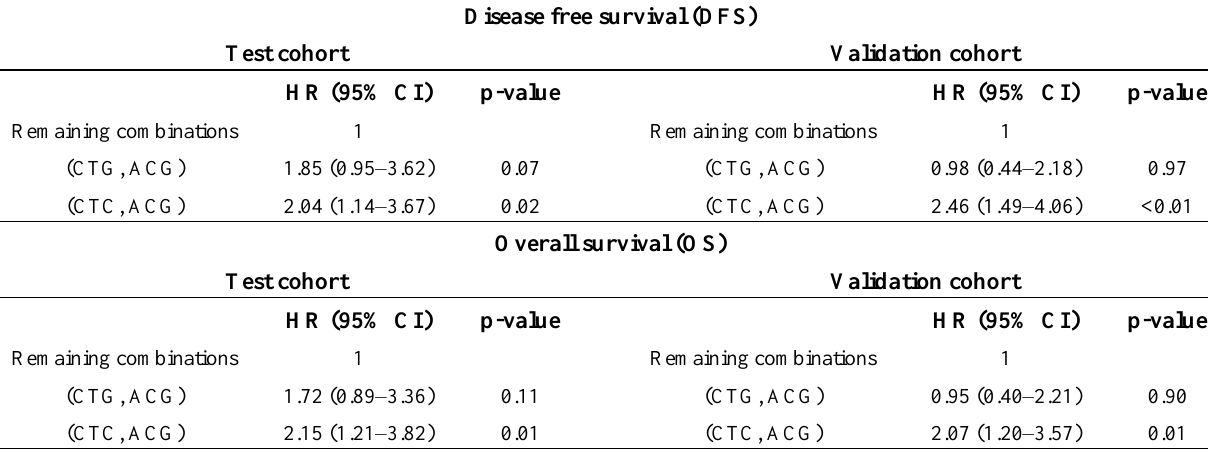
Table 4. Multivariate survival analysis according to haplotype combinations in both cohorts. All patients are